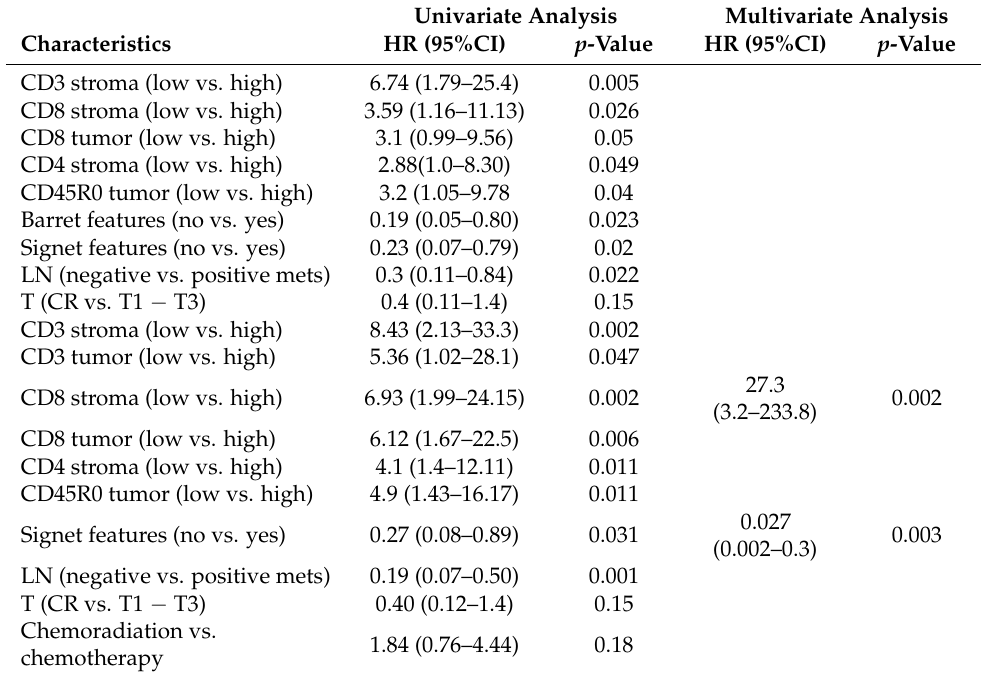
Table 2. Cox regression analysis for disease-free survival ( A ) and overall survival ( B ). LN—lymph node; mets—metastases; T—T stage; CR—complete response. Univariate Analysis Multivariate